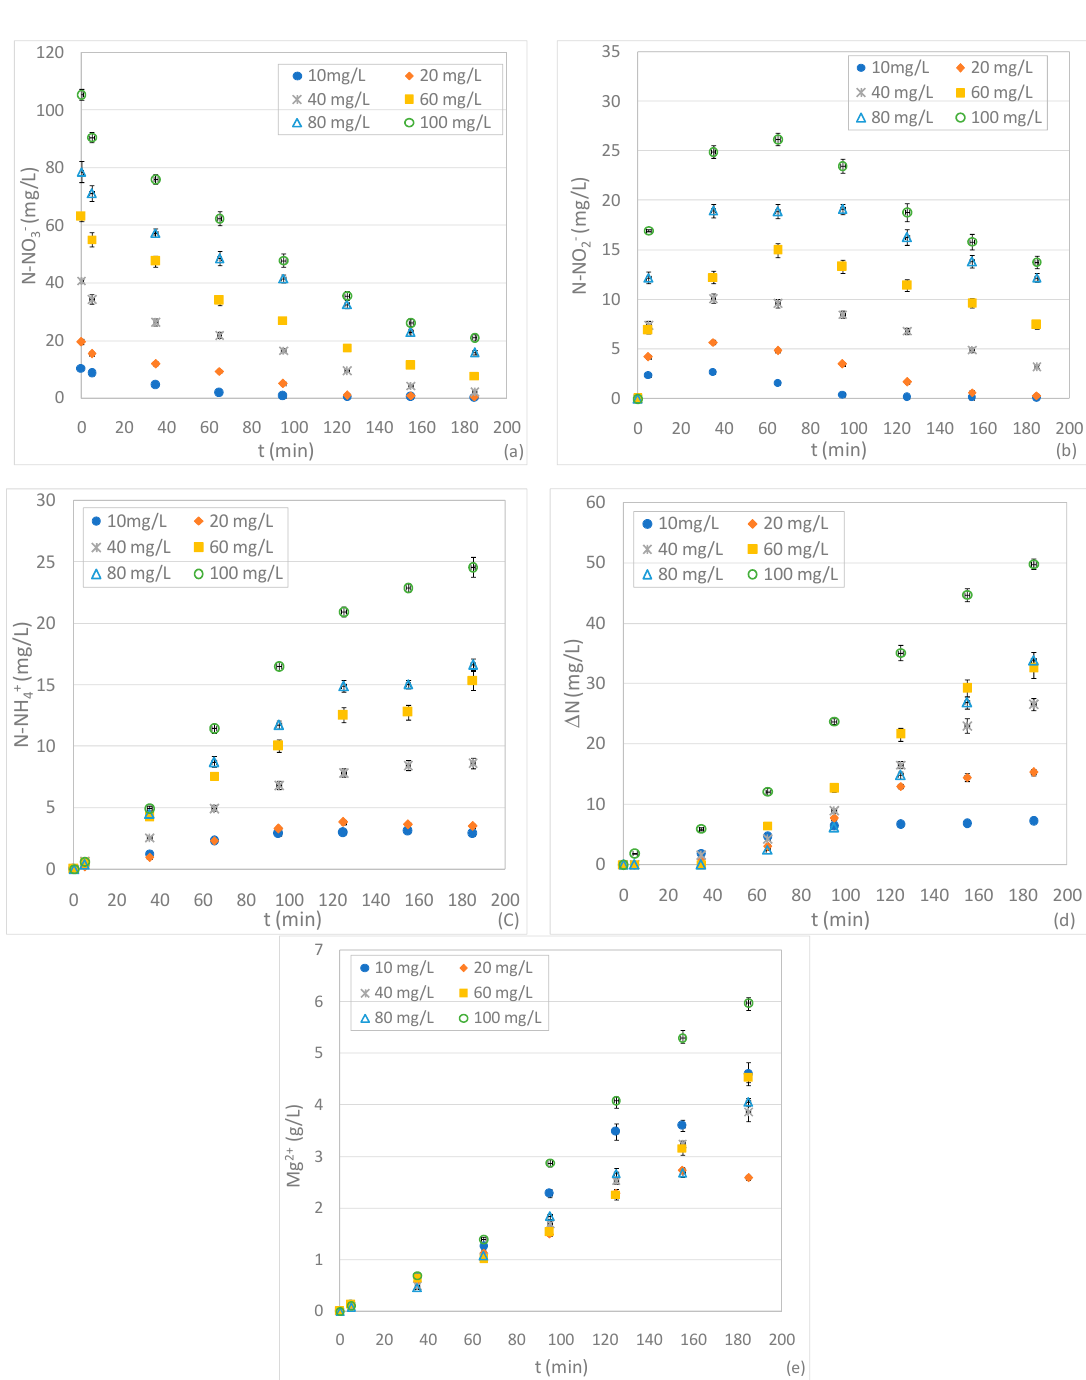
Figure 4. Concentrations of N-NO 3 − ( a ), N-NO 2 − ( b ), N-NH 4+ ( c ), Δ N ( d ) and Mg 2+ ( e ) during the tests carried out at pH 5, with 2g of Mg 0 ,varying the initial N-NO 3- concentration between 10 mg/L and 100 mg/L.